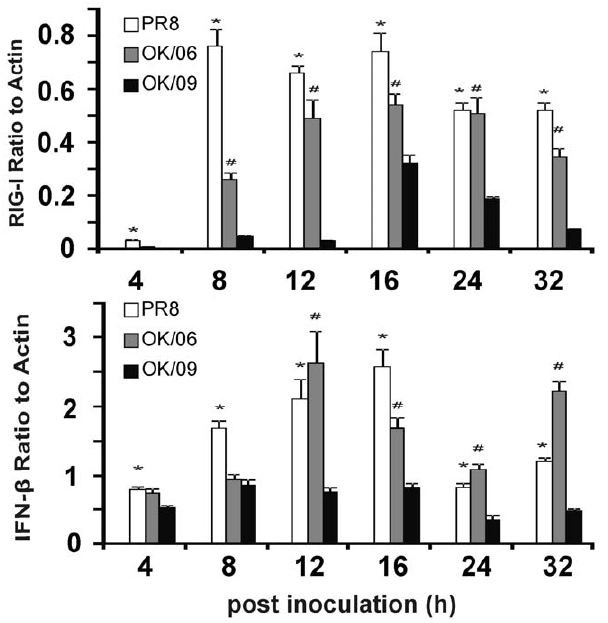
Figure 3. A time course study showing pandemic OK/09 impairs RIG-I and IFN- b antiviral immune responses compared to OK/06 and PR8 in human lung. Human lung slices were exposed to 6 6 10 6 PFU/ml of PR8 or OK/09 for 4 h, 8 h, 12 h, 16 h, 24 h, and 32 h. Total RNA was then isolated from lung slices. Quantitative RT-PCR was performed using 100 ng sample RNA and SYBR Green (Quanta Biosciences) in a BIO-RAD iCycler IQ instrument (Hercules, CA). Transcript levels of RIG-1 ( A ) and IFN- b ( B ) were normalized relative to the constitutively expressed b -actin gene. Data are from 3 separate experiments. *, p , 0.05 for PR8 to OK09. # , p , 0.05 for OK/06 to OK/09.